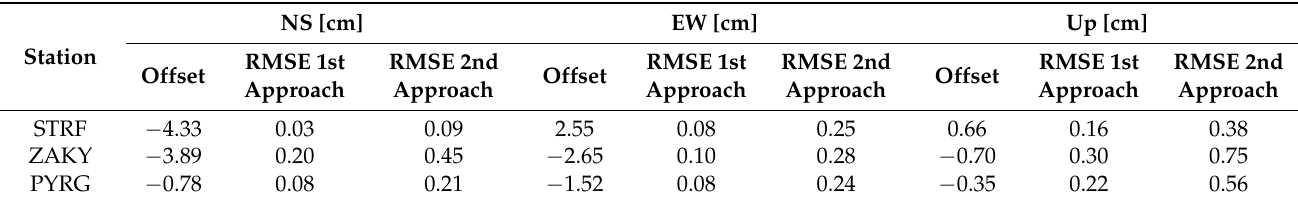
Table 2. Results of time series analysis before and after the earthquake in Zakynthos area with RMSE from the 1st and 2nd